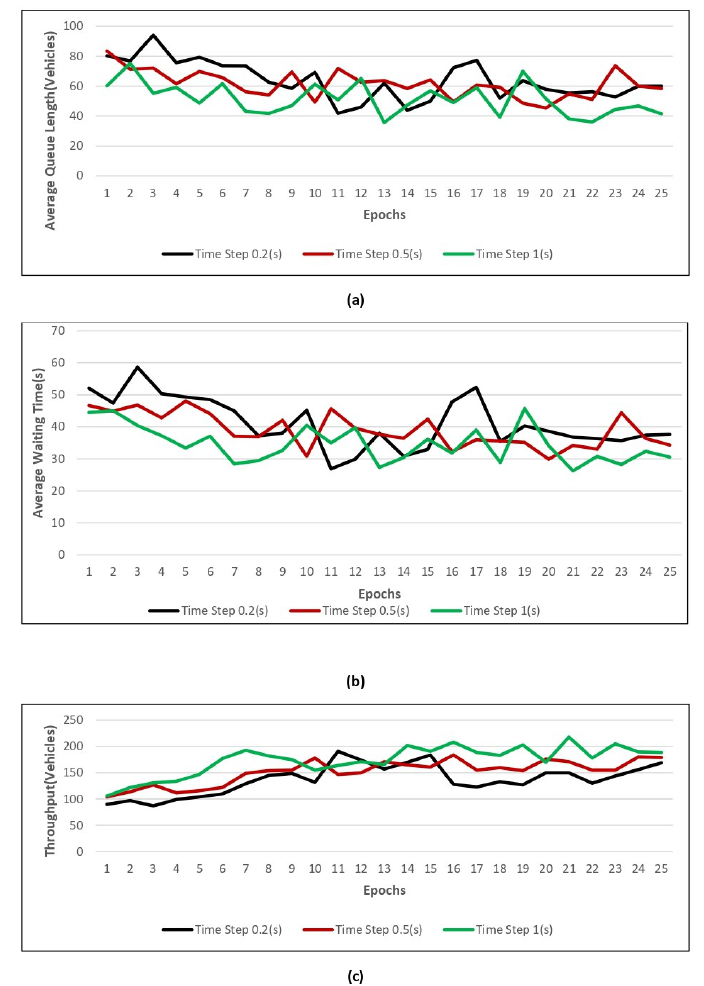
Figure 11. Performance results while training with three action time steps and using 25